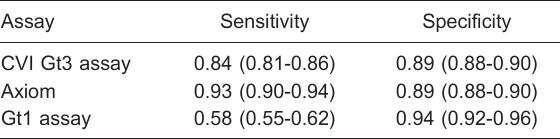
Table 3. Estimated sensitivity and